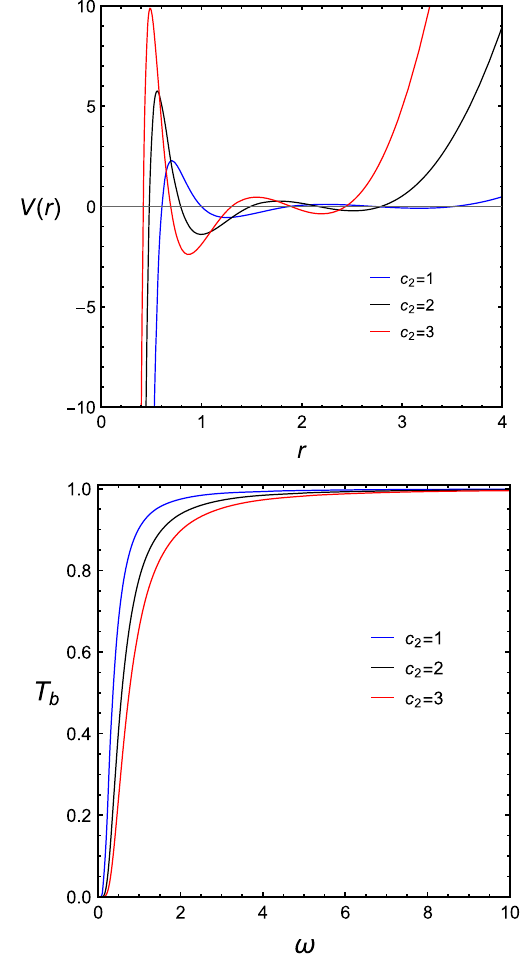
Fig. 8 These plots show the horizon structure, shape of the potential and the greybody factor bound for different values of c 2 , with M = 1 and β m = 0 .